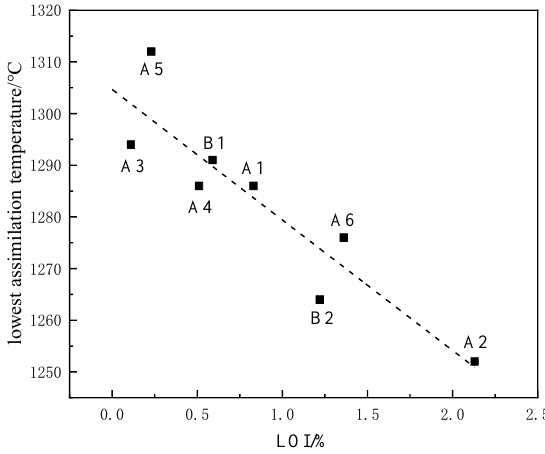
Figure 5. Influence of LOI on assimilation temperature. It can be seen from Figure 6 that the assimilation temperature showed a downward trend with increased Al 2 O 3 content. Increasing the Al 2 O 3 content in the iron ore powder sample can reduce the assimilation temperature, which is mainly related to the liquid-phase state in the sintering process, especially in magnetite sintering. In the oxidation atmosphere of the cooling crystallization stage, magnetite is oxidized to hematite in large quantities. If the Al 2 O 3 content in iron ore powder is increased, the surface tension of the liquid phase increases, the contact surface of oxygen increases, the transformation of hematite